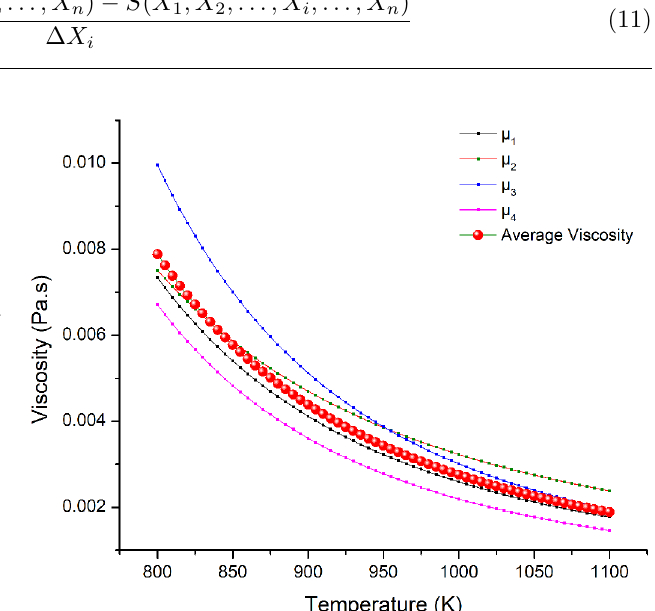
Fig. 7. Temperature dependent correlations for viscosity and the average viscosity function obtained by exponential